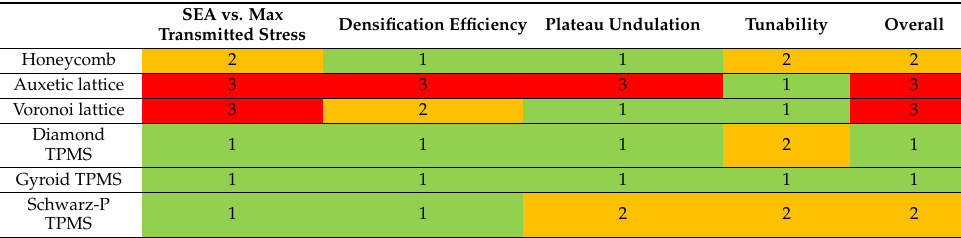
Table 3. Comparison matrix for all shapes studied in this work. SEA vs. Max Transmitted Stress Densification Efficiency Plateau Undulation Tunability Overall Honeycomb 2 1